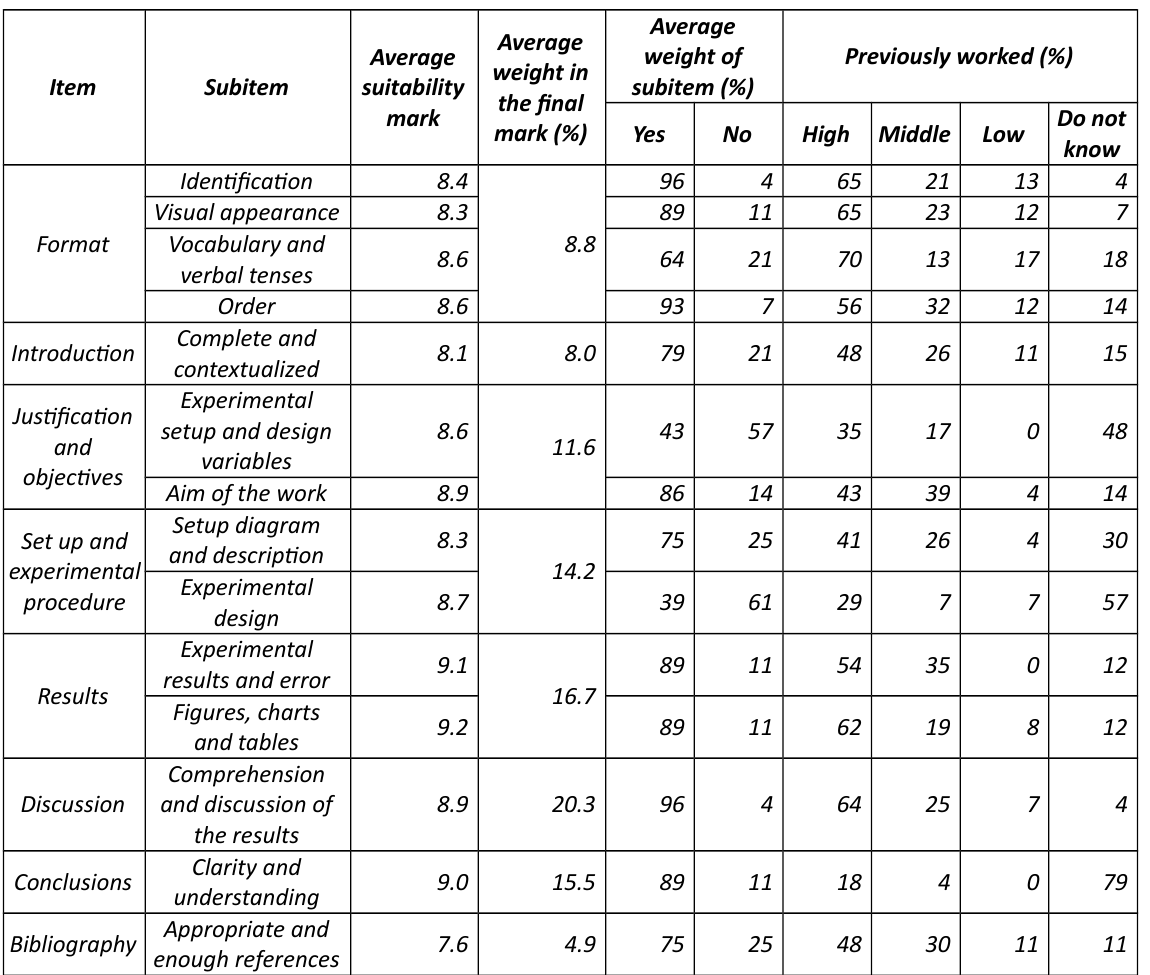
Table 5. Analysis of the results of the validaton of the rubric for writen communicaton